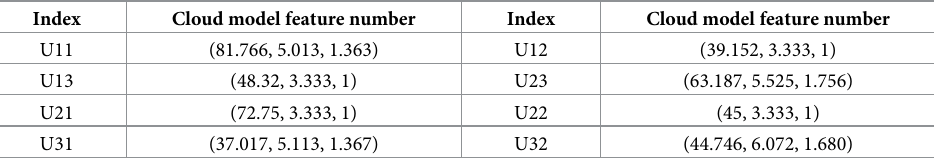
Table 4. Characteristic parameters of the weighted cloud model for each landslide